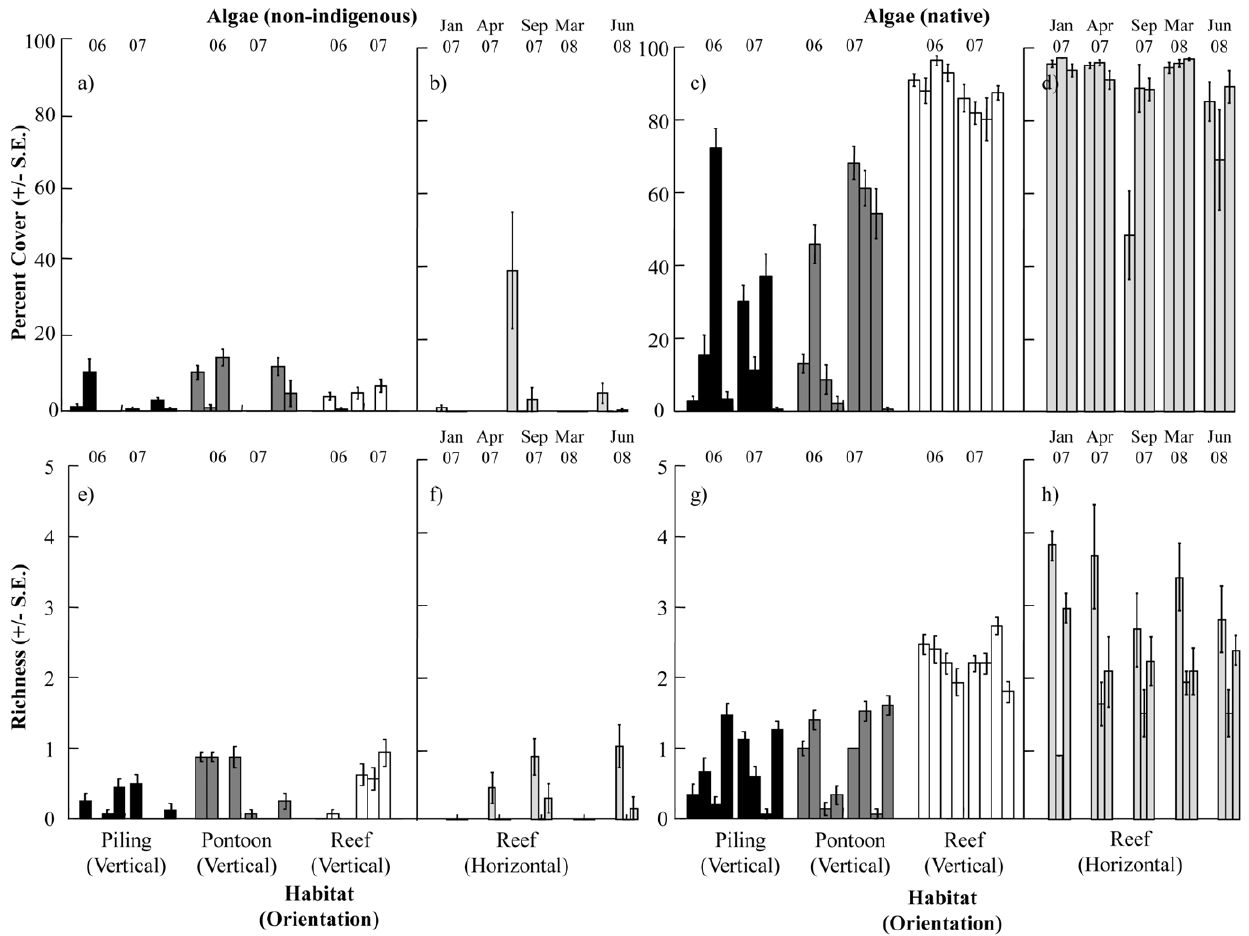
Figure 4. Percent cover and richness of algae sampled on vertical surfaces of artificial and natural habitats and horizontal reef. Non- indigenous algae sampled from (a, e) vertical surfaces of habitats and (b, f) horizontal reef and native algae sampled from (c, g) vertical surfaces of habitats and (d, h) horizontal reef. In-situ sampling was conducted at four sites in 2006 and 2007. Individual bars represent sites ordered BA, FT, GB and CL from left to right. Sampling years (06/07) are indicated above the bars. Percent covers for horizontal reef were sampled in a separate survey at three sites at five sampling times (Jan 07, Apr 07, Sep 07, Mar 08, Jun 08). Individual bars represent sites ordered BA, FT, GB from left to right for each sampling